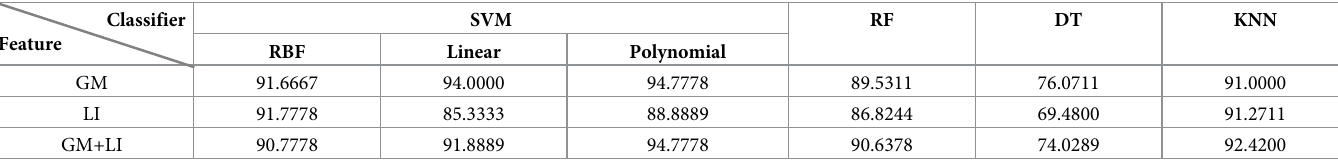
Table 3. Classification results in EMCI versus LMCI under three kinds of